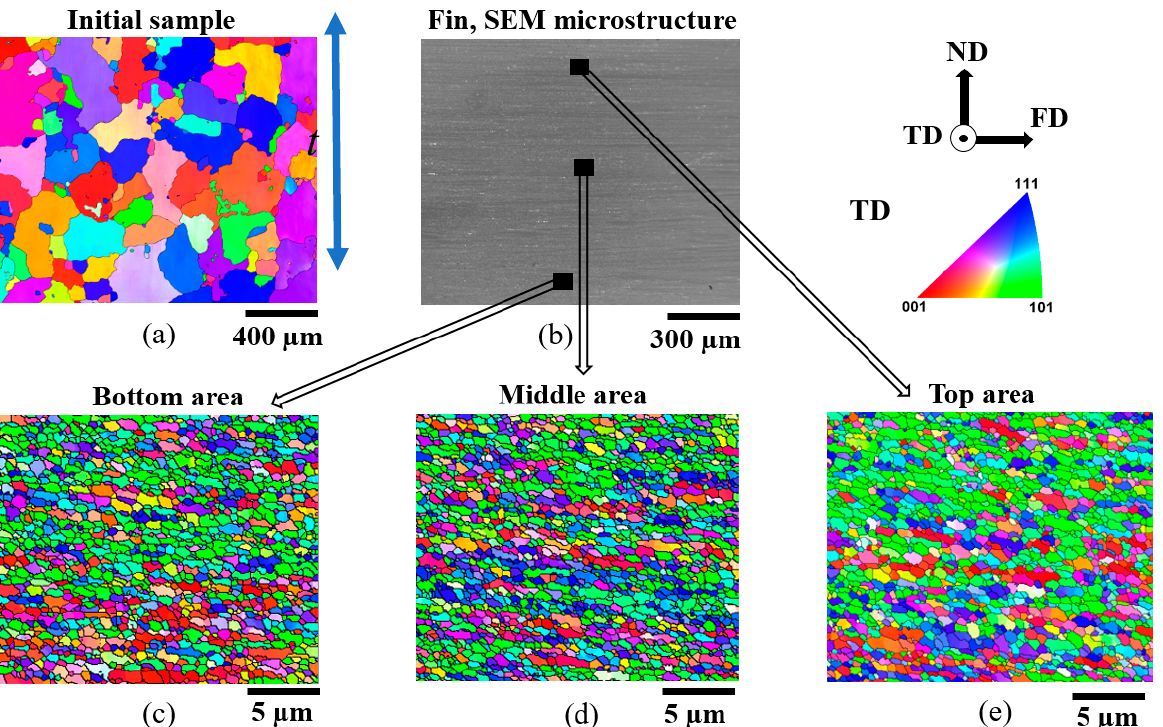
Figure 4. ( a ) EBSD microstructure of the initial sample; ( b ) SEM microstructure across the thickness of the produced fin; ( c – e ) EBSD microstructures of the bottom, middle, and top areas of the Al-1050 produced fin, respectively.